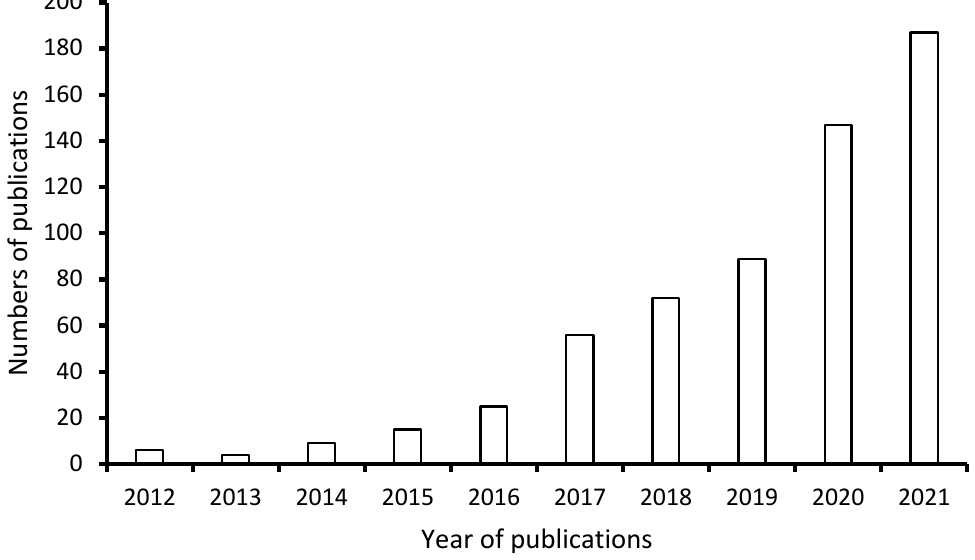
Figure 1. Scientific publications on nanocellulose crystal-based membranes for wastewater treatment (data extracted from www.sciencedirect.com on 14 July 2021 from Science direct, using the keywords “nanocellulose crystal”, “membrane”, and “wastewater treatment”).